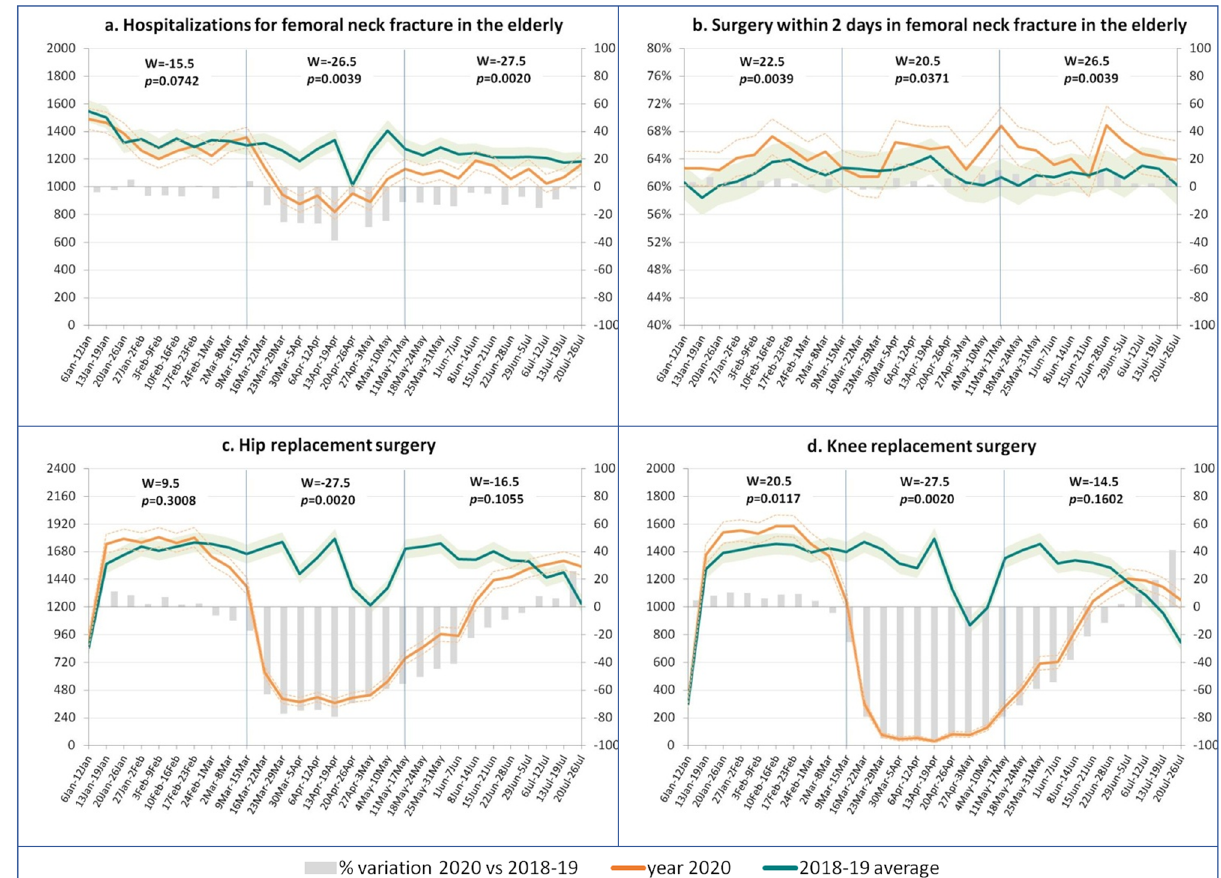
Figure 3. Impact of Covid-19 on orthopaedic hospital care in Italy: volumes and performance by sub-period*. Weekly trend of indicators (left axis) with 95% CI and % variations (right axis)—January–July 2020